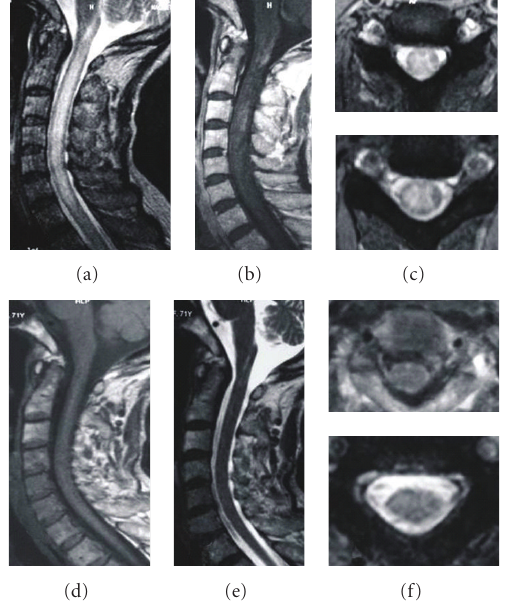
Figure 6: A 70-year-old female was admitted due to progressive paraparesis, paresthesias, and urinary retention for 2 months. After 2-year of ATT, her situation improved. The MRI changes are as follows: (a) sagittal T2-weighted image reveals a long, high intensity signal from C1 to T1 in the spinal cord before treatment regimen, (b) T1Wcontrast image showingpatchy enhancement and thickening of the cord, (c) the di ff use lesions on axial T2-weighted images, (d) a year later the swelling of the cervical spinal cord disappeared on sagittal T1-weighted images, (e) the hyperintensity resolved following 1 year of ATT, and (f) no lesion is visible on axial T2-weighted images.